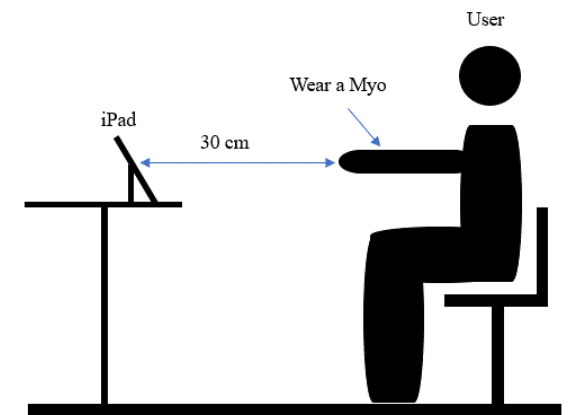
Figure 5. Example of a virtual keyboard of this system.